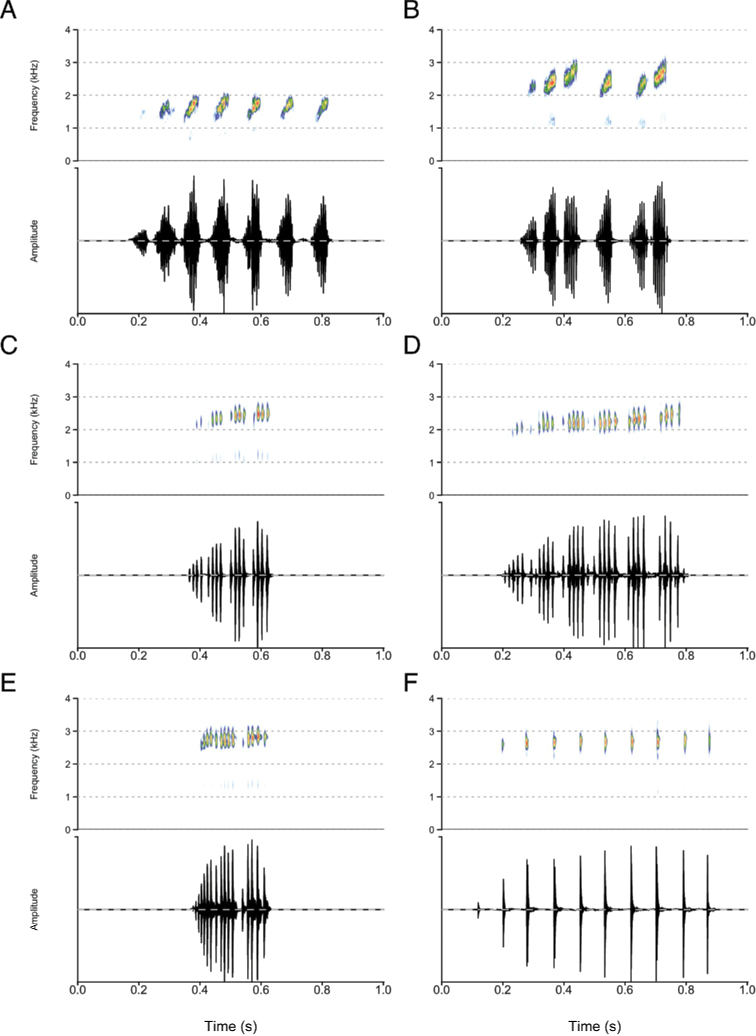
Spectrograms and oscillograms of calls of the cooperi and erlangeri species groups AP.
cooperiBP.
amharensisCP.
erlangeriDP.
levenorumEP.
nanaFP.
robeensis sp. nov.